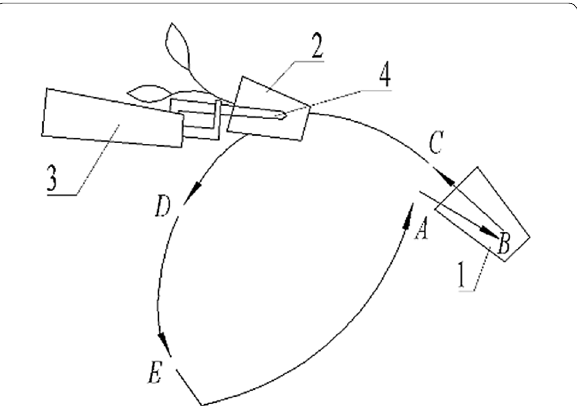
Figure 1 Schematic of the seedling pick-up trajectory: 1. seedling pot, 2. seedling, 3. pick-up arm, and 4. pick-up